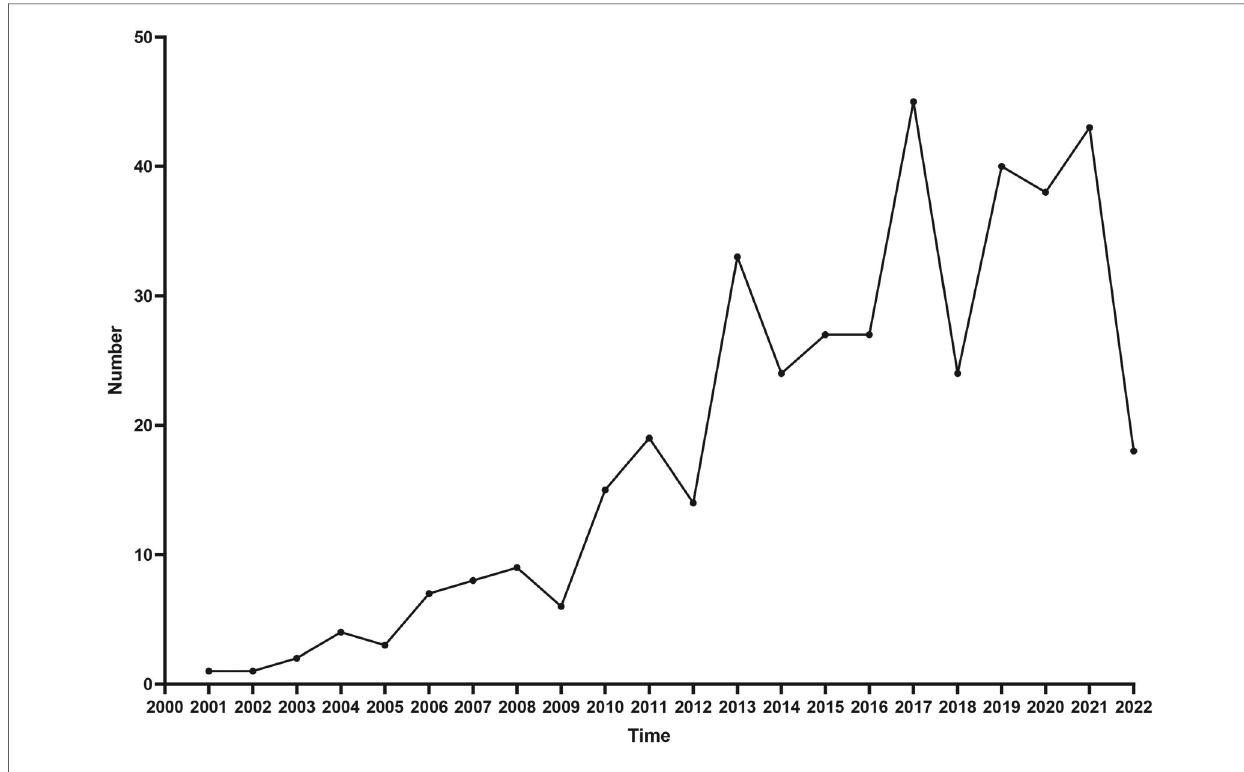
FIGURE 4 Number of trials on ClinicalTrials.gov by pediatric echocardiography per year.